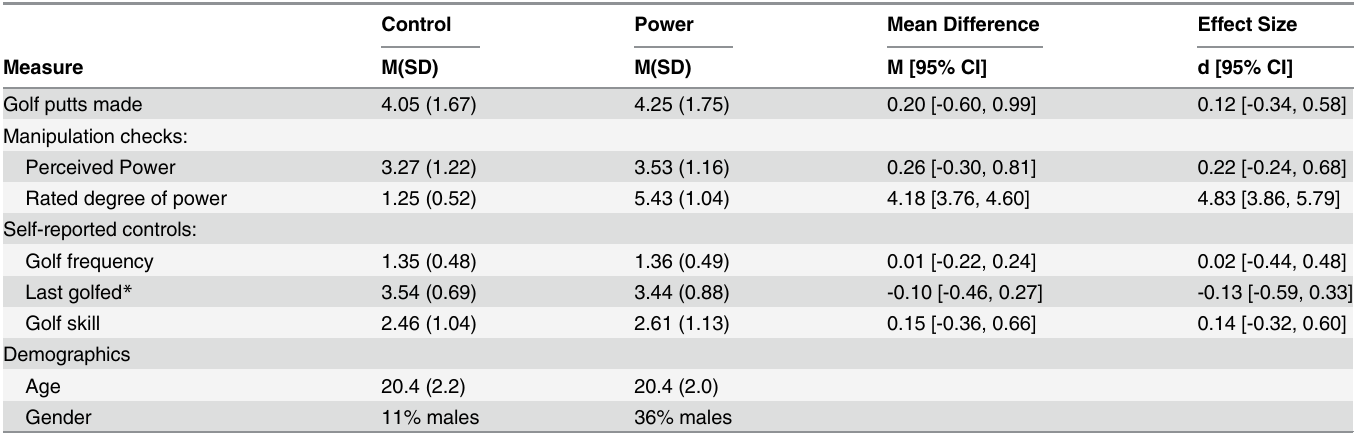
Table 1. Experiment 1: Summary of Group